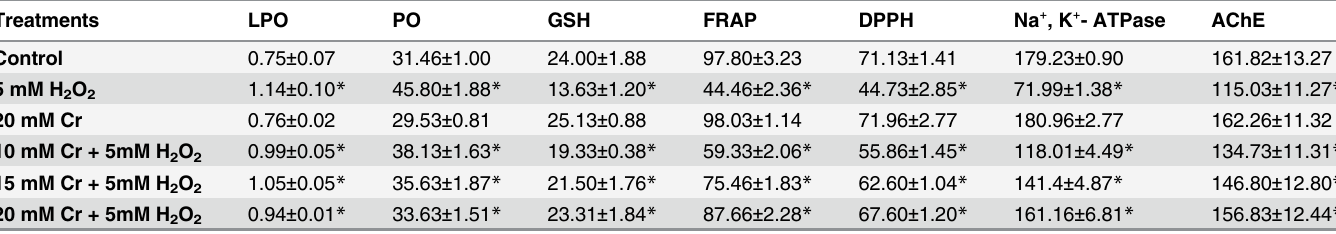
Table 4. Effect of creatine on H 2 O 2 -induced changes in some lymphocyte parameters.